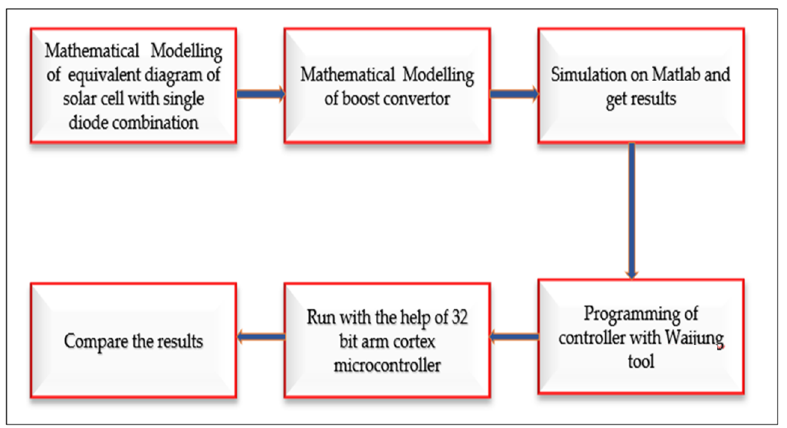
Figure 3. Block diagram of the workflow.